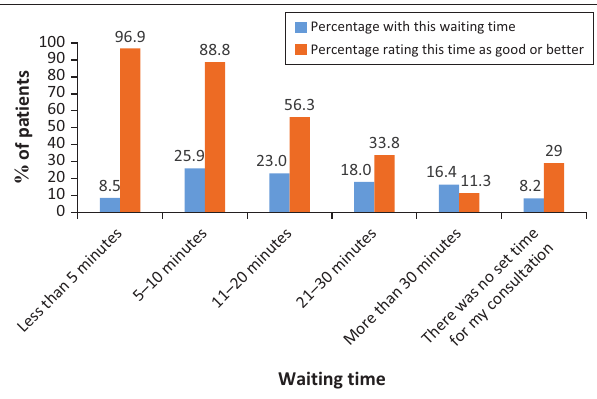
FIGURE 1: Waiting time and patient satisfaction ( N =